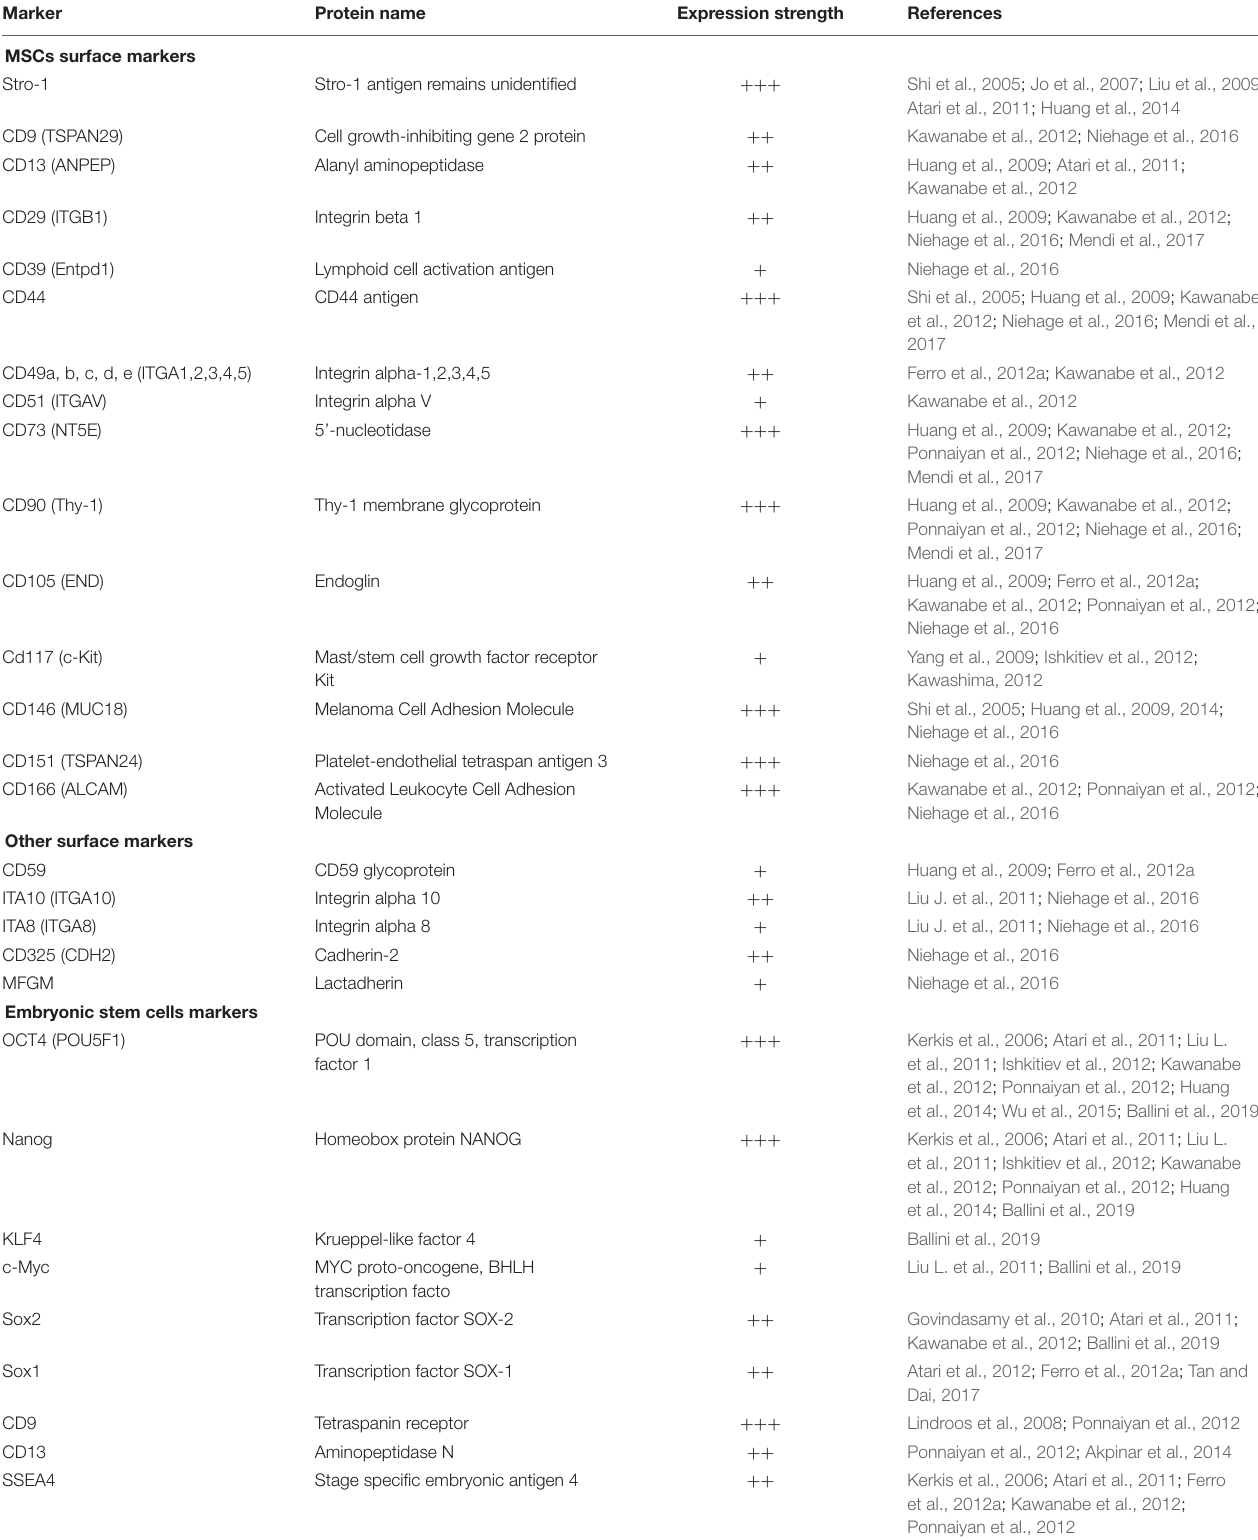
TABLE 1 | Surface markers and pre-lineages expression profile of dental pulp stem cells (DPSCs). Marker Protein name Expression